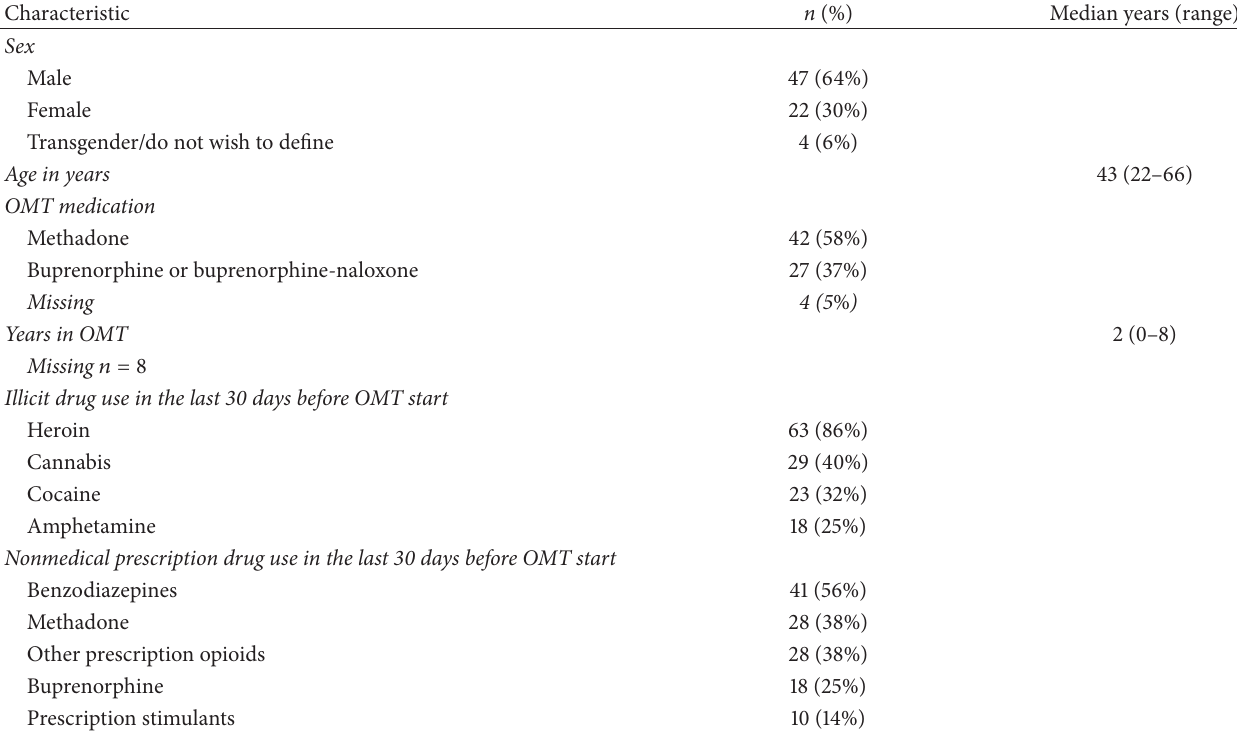
Table 1: Sample characteristics among opioid maintenance treatment patients in Malmo, Sweden ( 𝑁 = 73 ).